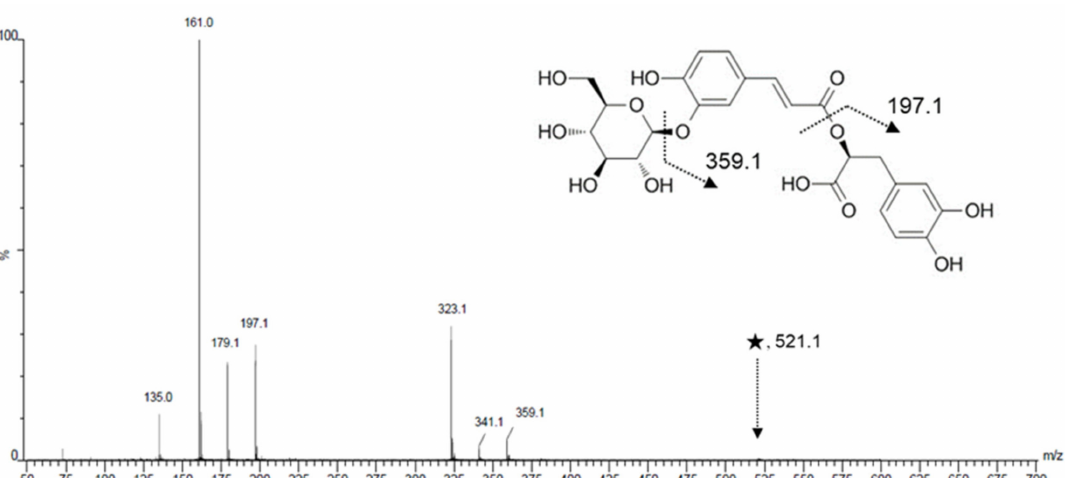
Figure 3. Tandem mass spectrum and fragmentation pattern of glucopyranosyl rosmarinic acid obtained by SYNAPT G2, HR–ESI–MS/MS. The symbol (cid:70) represents the precursor ion, [M-H] -